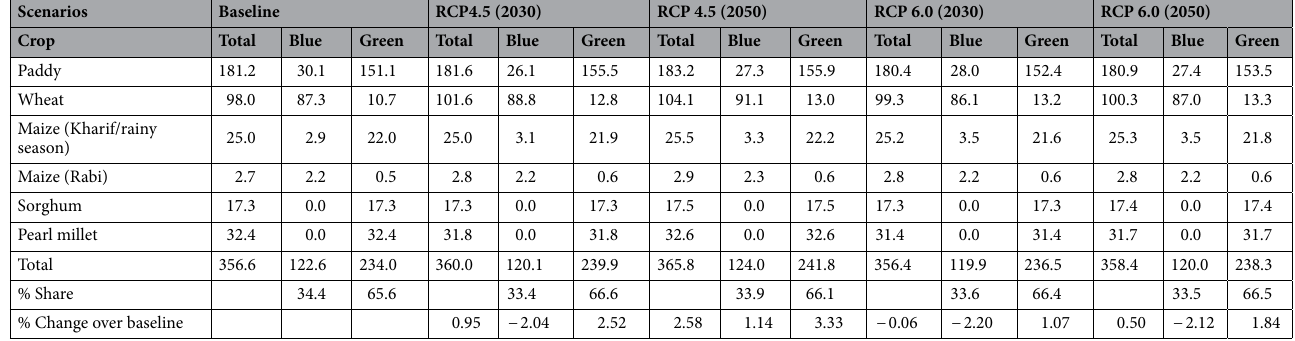
Table 1. WF of selected cereal crops under different climate change